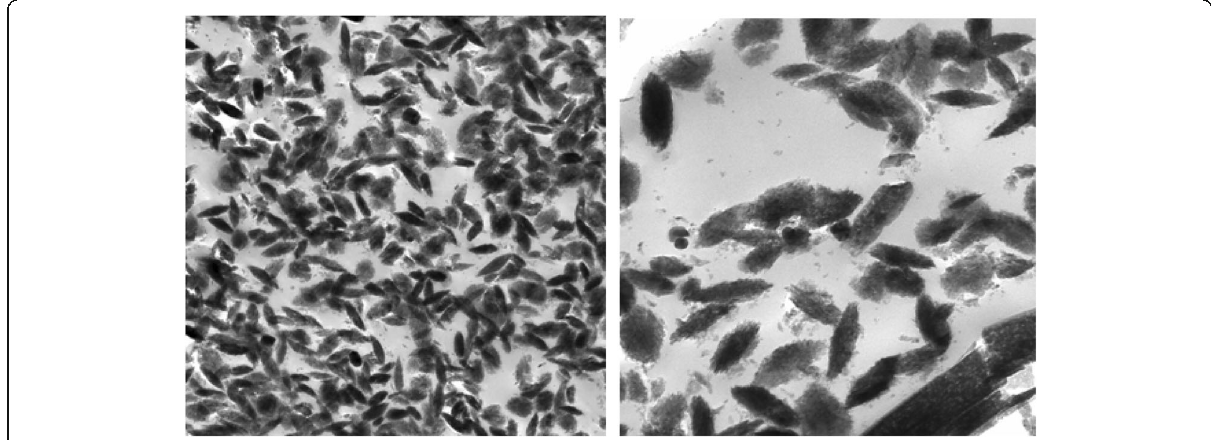
Fig. 4 TEM analysis of nano hybrid particles